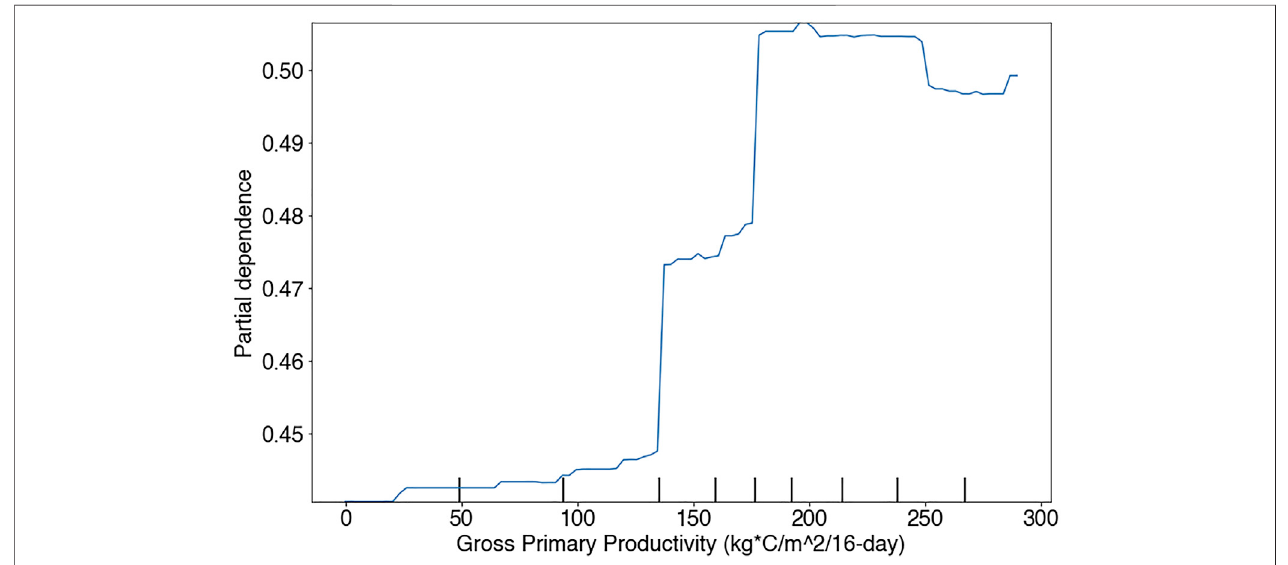
FIGURE 11 | Partial dependency plot showing RBT occurrence model performance against Gross Primary Productivity in the Flathead basin study region.